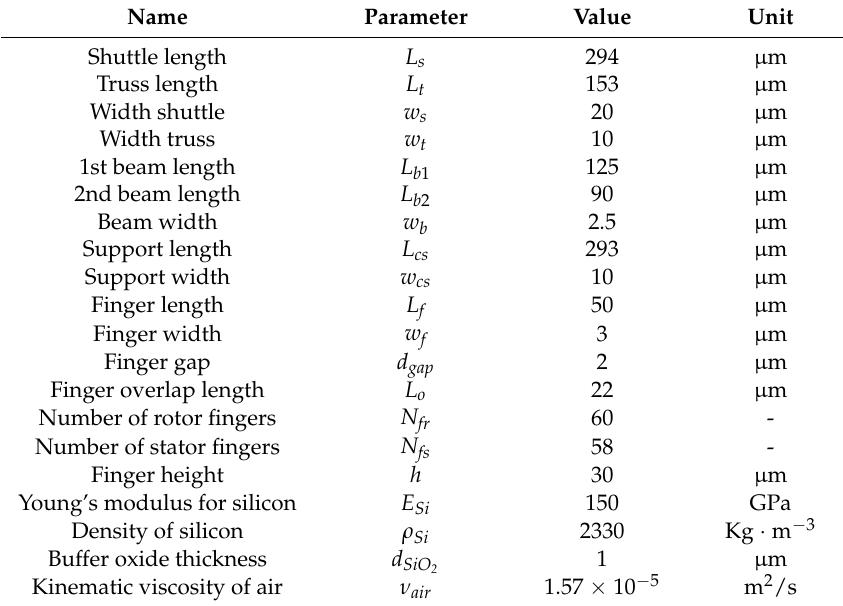
Table 1. Dimensional and material properties for test comb drive